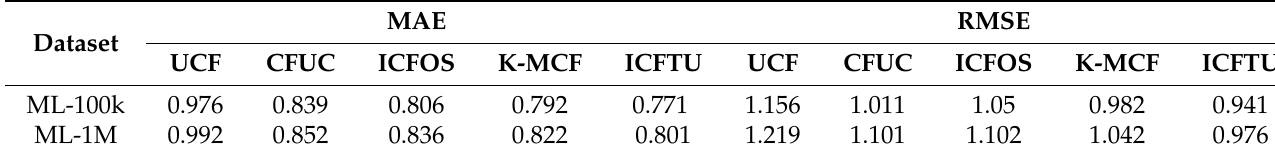
Table 2. The results of the comparison experiments.